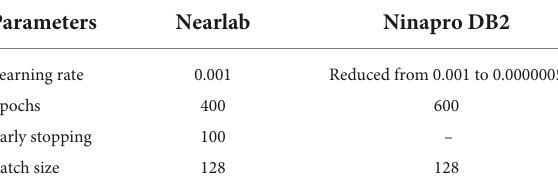
TABLE 2 Learning parameters of Cnet1D and Cnet2D for Nearlab and Ninapro DB2